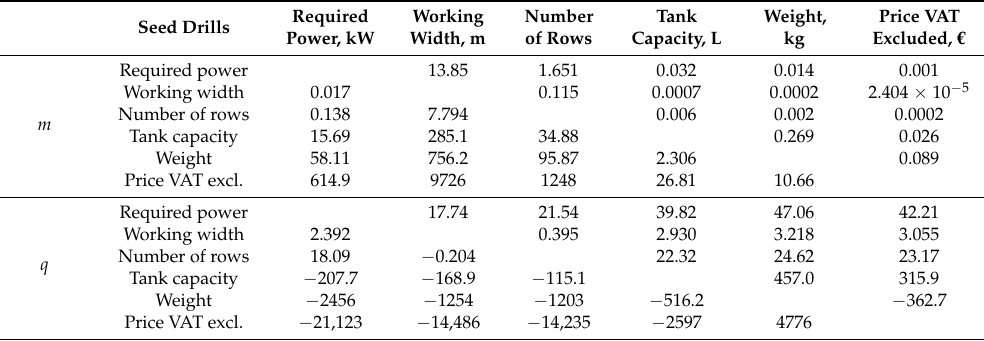
Table 4. Linear coefficient and intercept matrix for functional parameters of seed drills. Seed